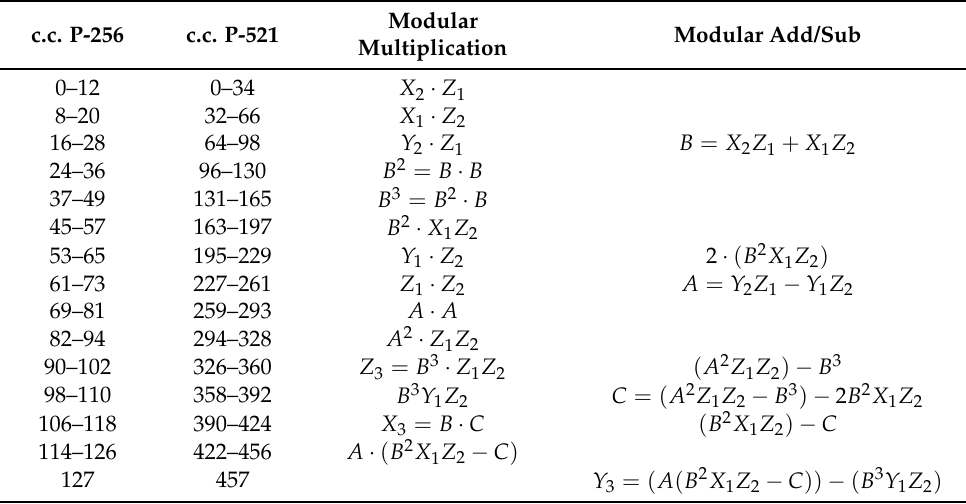
Table 2. PA Operations Scheduling (c.c. stands for clock cycles).